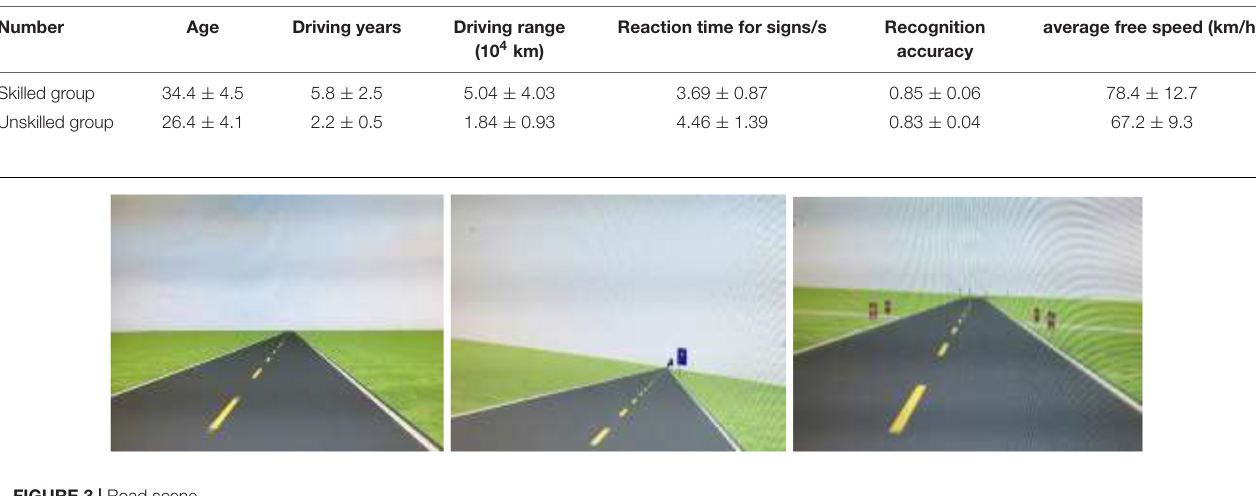
FIGURE 3 | Road scene.